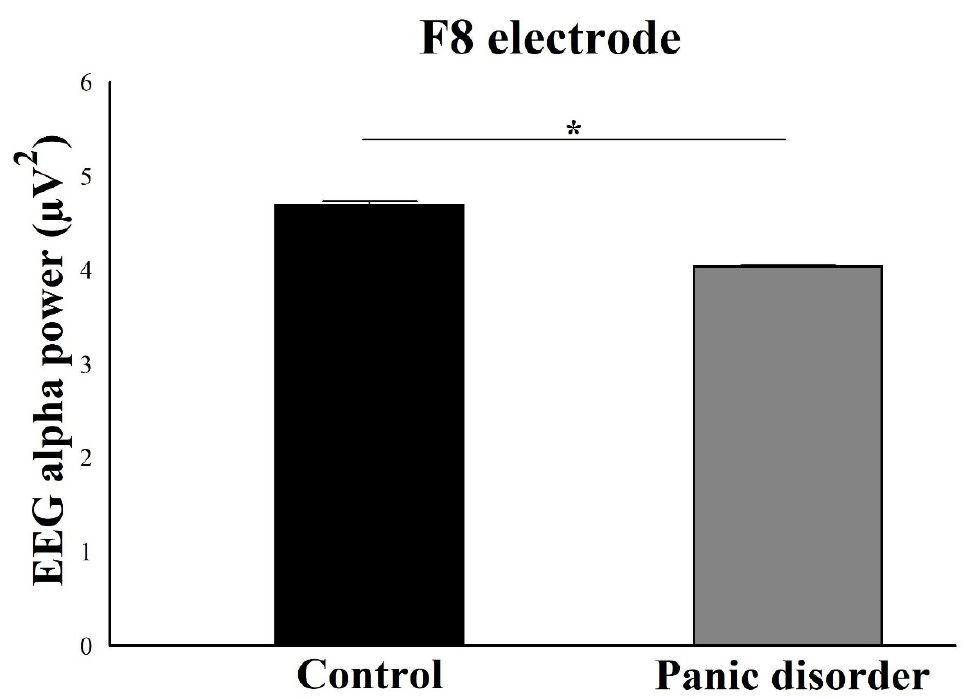
Figure 9. Main effect for group ( p = 0.001). The EEG alpha power for F8 electrode decreases in the experimental group compared to the control group. The result is represented by the mean ± standard error and the statistically significant difference is indicated with *, p < 0.05).